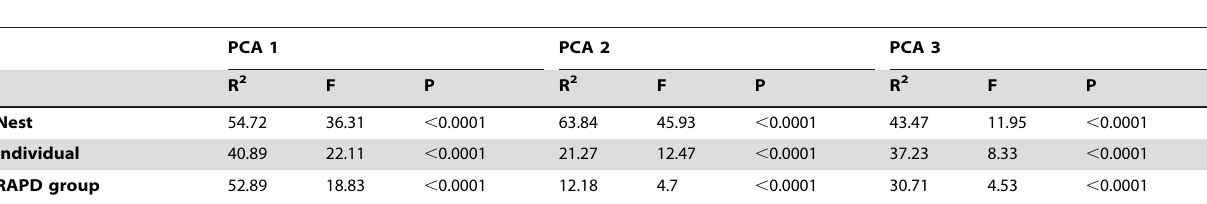
Table 2. Univariate results of the percentage of variance explained (R 2 ) by each predictor variable in the three PCA